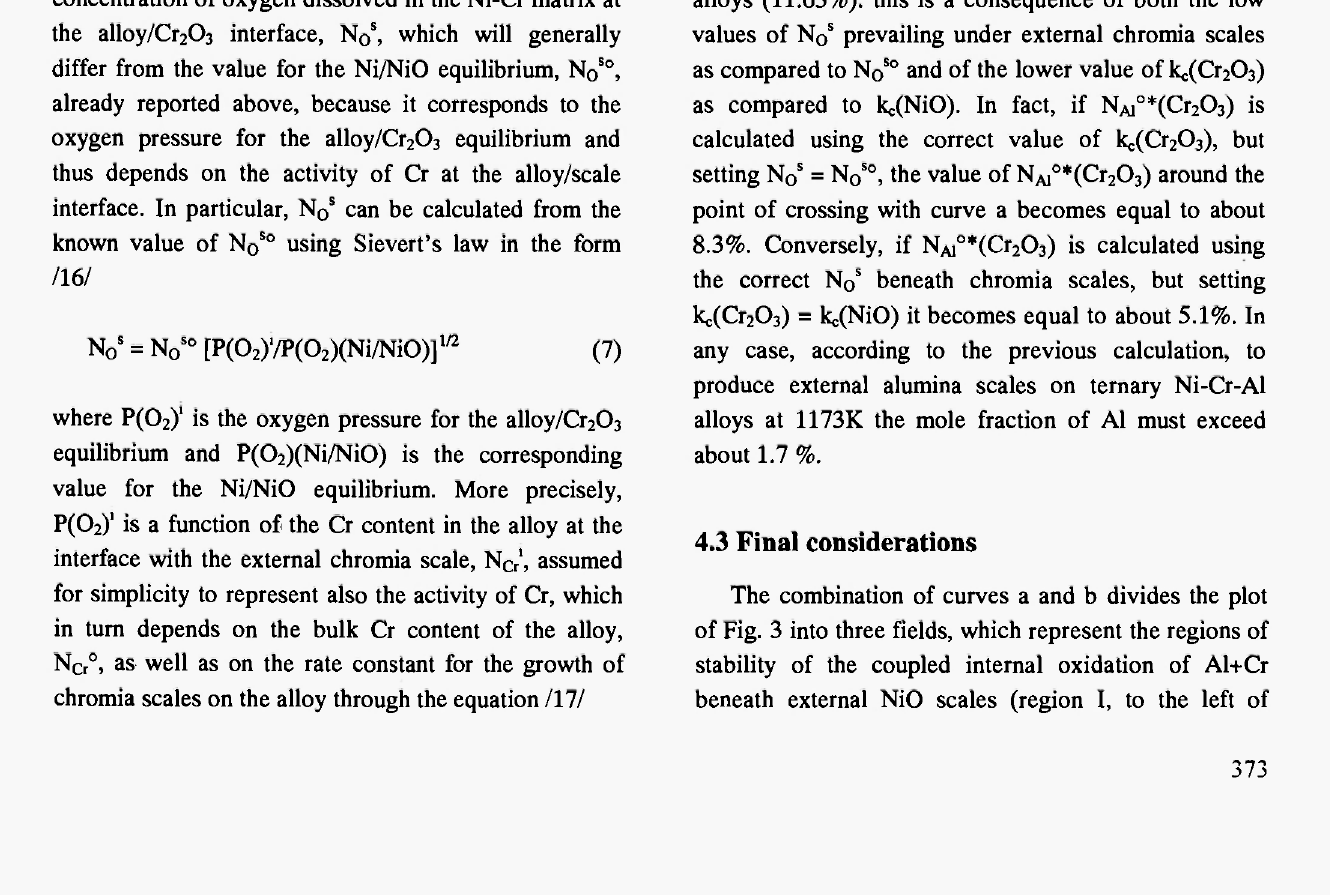
scales and the Cr content at the alloy-scale interface: because it is not well known, so that kc(Cr 2 0 3 ) is simply taken as a constant under constant temperature. In particular, according to the results by Giggins and Pettit on the oxidation of binary Ni-Cr alloys /13/, kc(Cr 2 0 3 ) at 1173K is equal to 1.3xl0" 17 m V. Finally, the possible effect of the presence of Cr in the Ni-Cr matrix of the zone of internal oxidation on the solubility of oxygen in the alloy /18/ is also neglected. Solution of the system of Eqs.(5-6) with the help of Eqs.(7-8) using